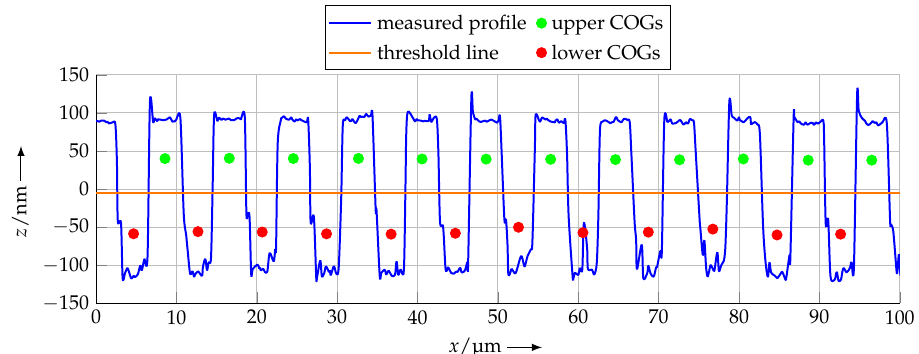
Figure 8. Calculated COGs for the scanned profile (detail). In the x direction, the COGs are located at the position where the area of the according profile element is divided into two equal parts. The z position of the COGs is not relevant for the pitch calculation and introduced for descriptive purposes only.